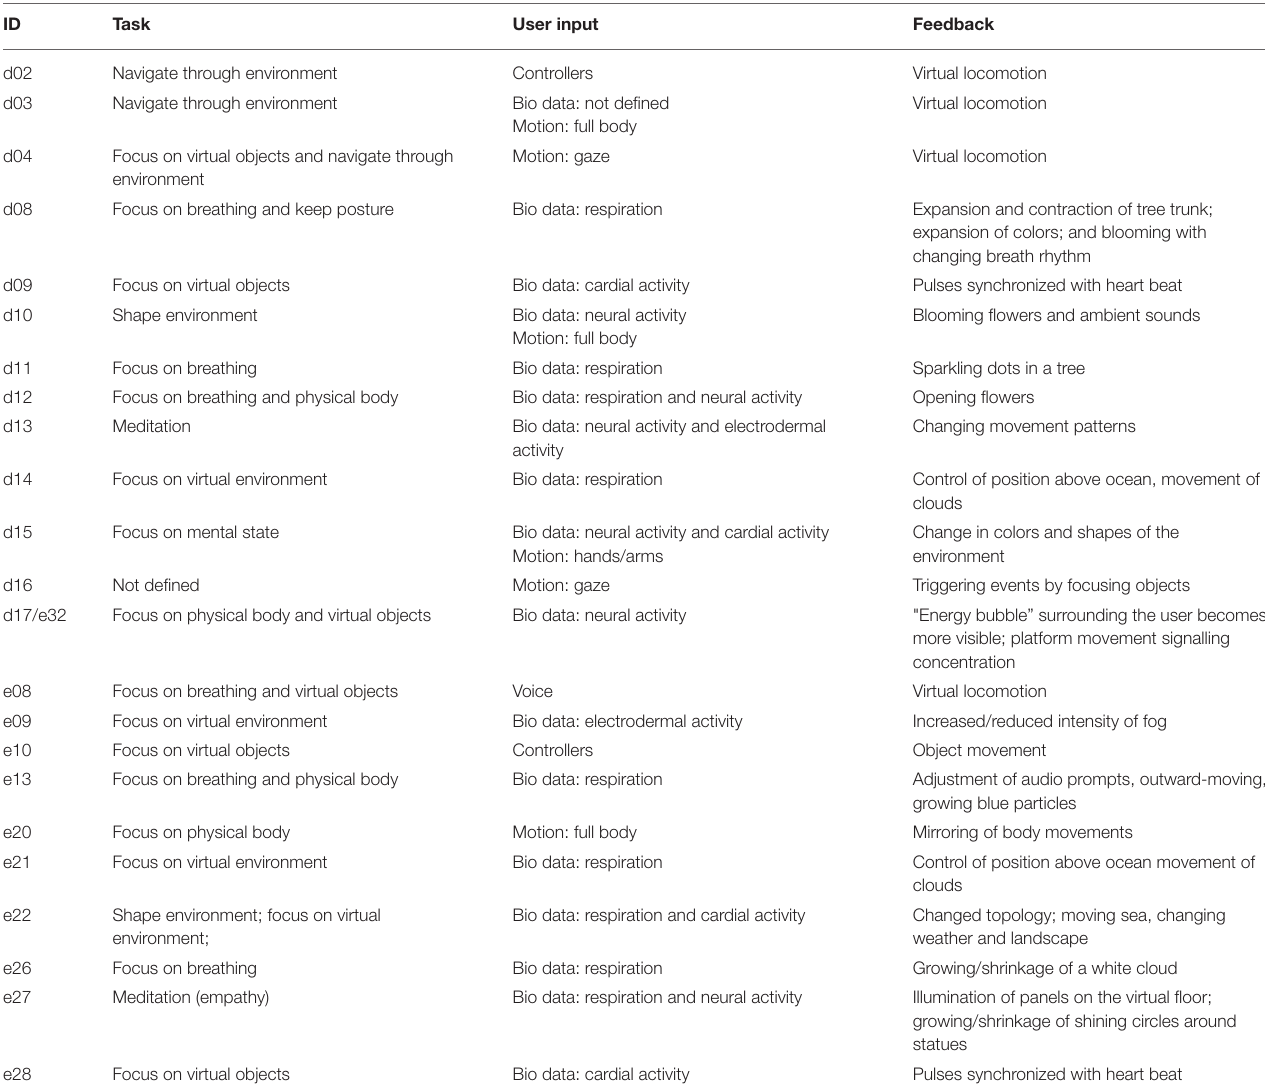
TABLE A1 | Tasks, user input, and feedback presented in the papers with interactive mindfulness